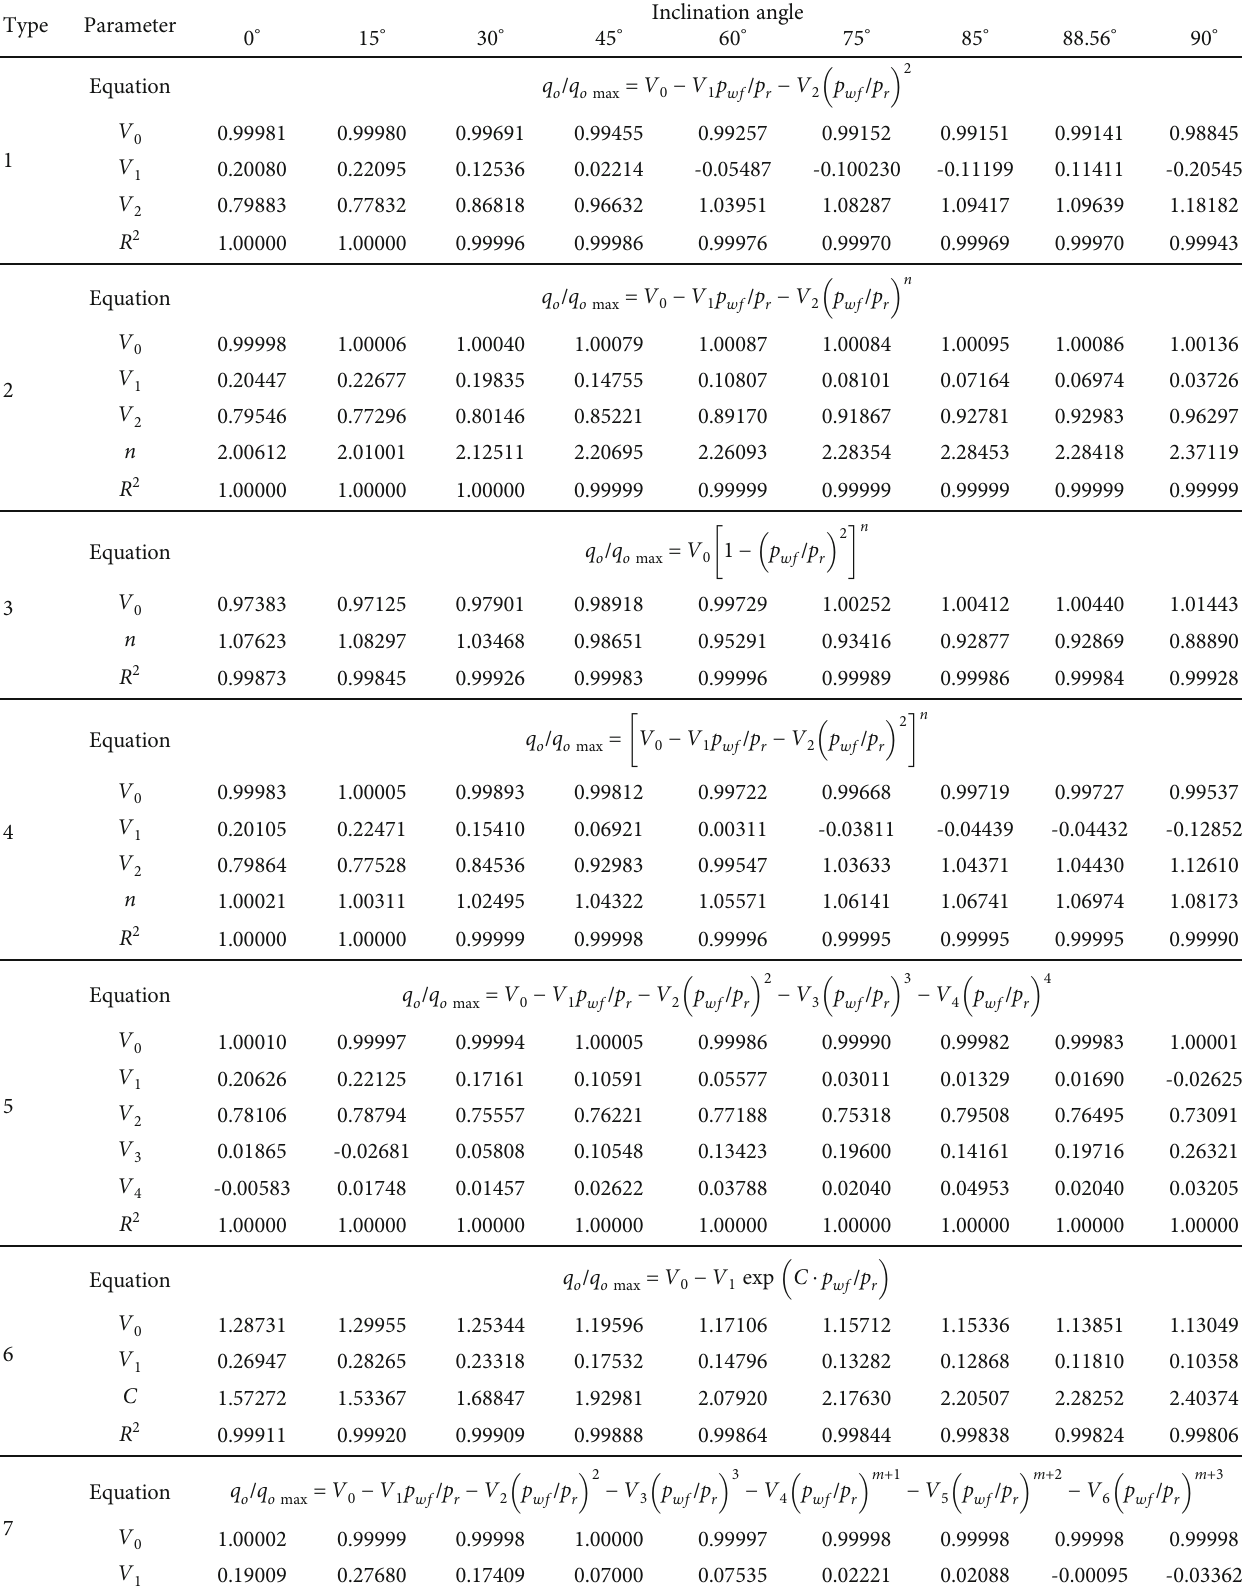
Table 3: Fitting values of undetermined parameters of in fl ow performance equations for di ff erent types of inclined wells.